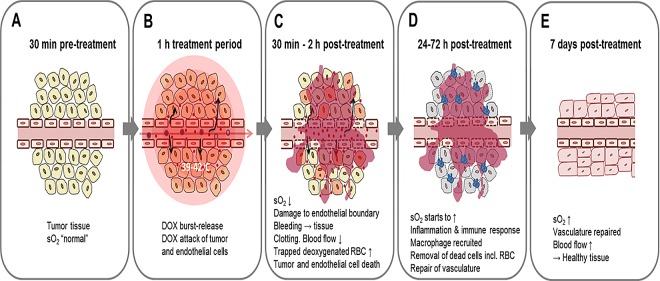
Proposed mechanism and levels of oxygen saturation (sO2) following treatment with a burst-release TSL such as HaT-DOX triggered with mild-hyperthermia.The timecourse is represented as a number of snapshots which appear sequentially from A-E.